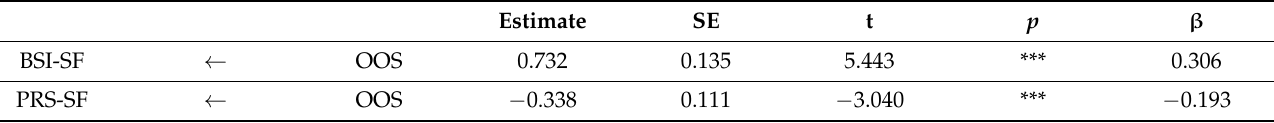
Table 8. Values of variance explained, standard error, t, p , and standardized regression coefficients. Estimate